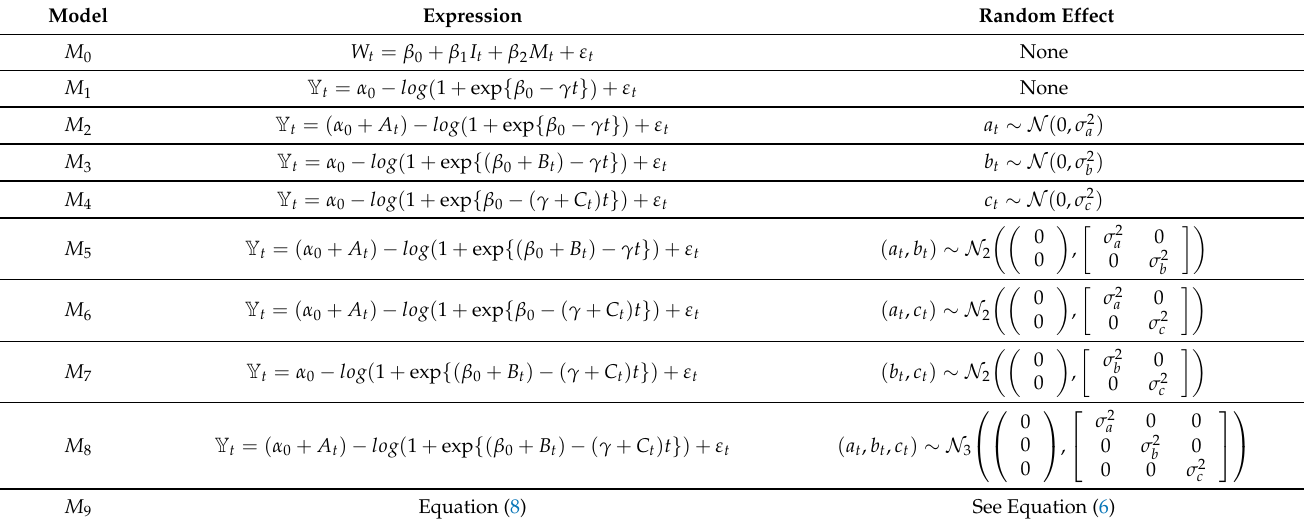
Table 3. The considered models.